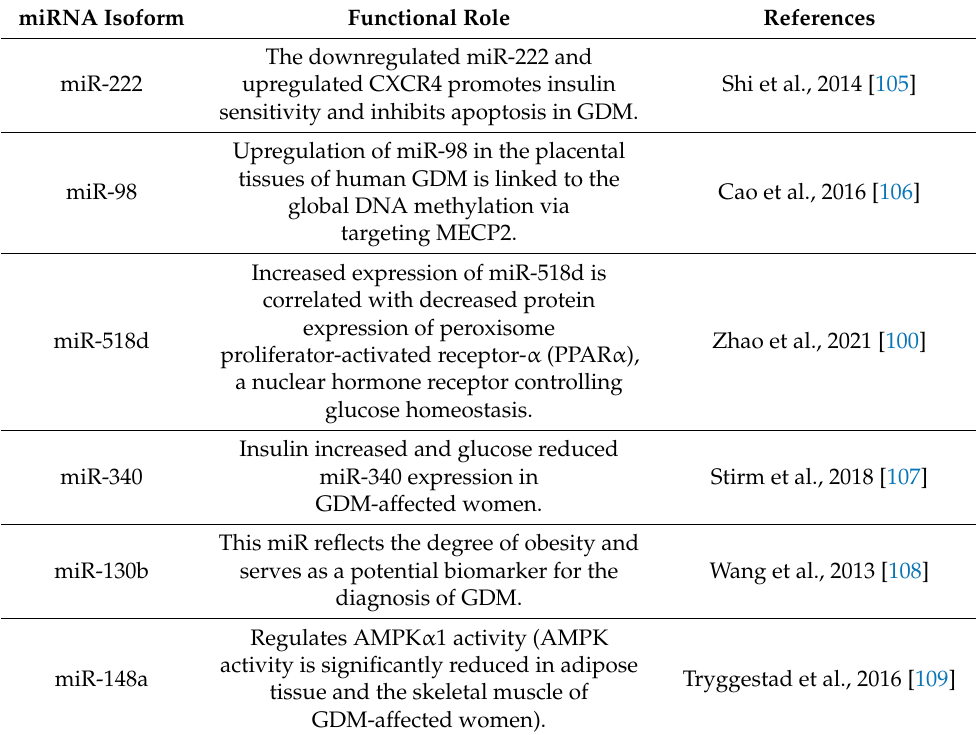
Table 1. List of miRNAs involved in the pathophysiology of GDM. miRNA